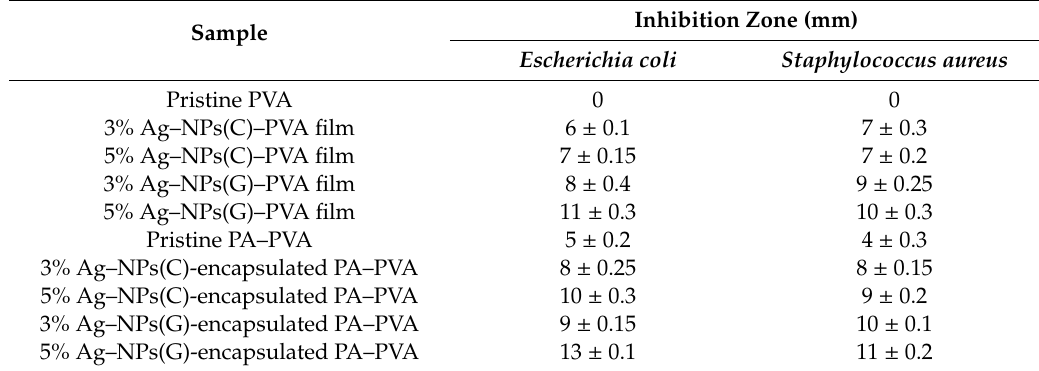
Table 3. Antibacterial activities of various as-prepared